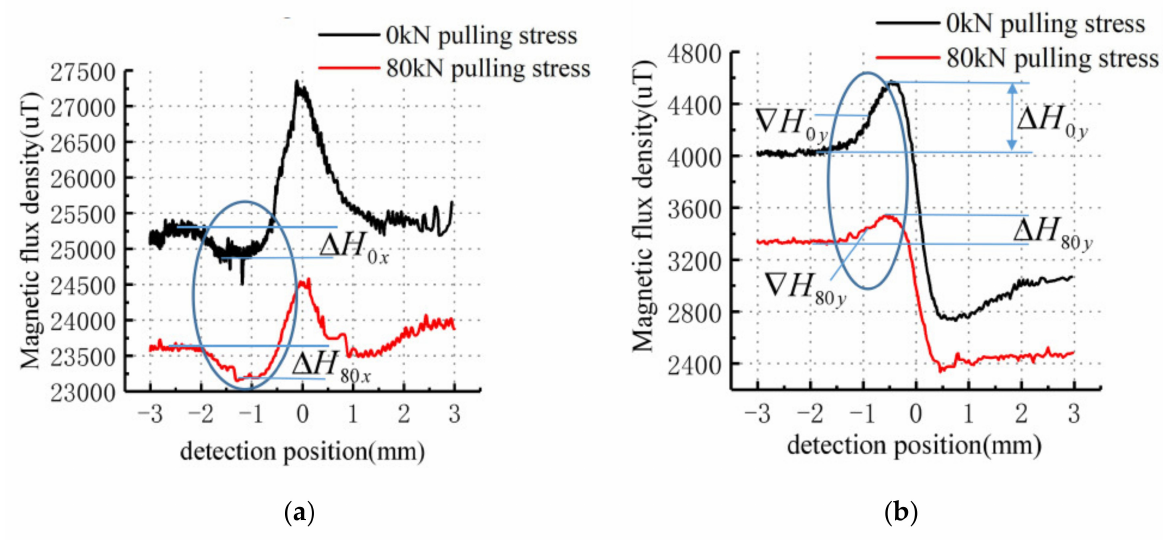
Figure 20. The MFL signals of specimen 2 under different stresses: ( a ) Tangential signal; ( b ) Normal